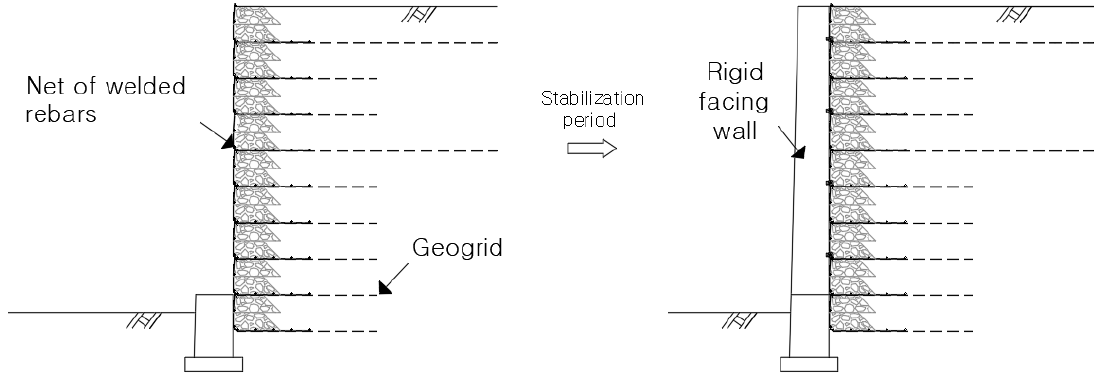
Figure 2. Concept drawing of RSR.